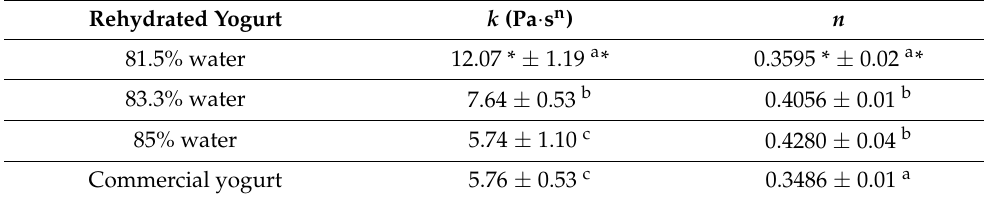
Table 6. Determination of the viscosity ( k and n parameters) of rehydrated yogurt. Rehydrated